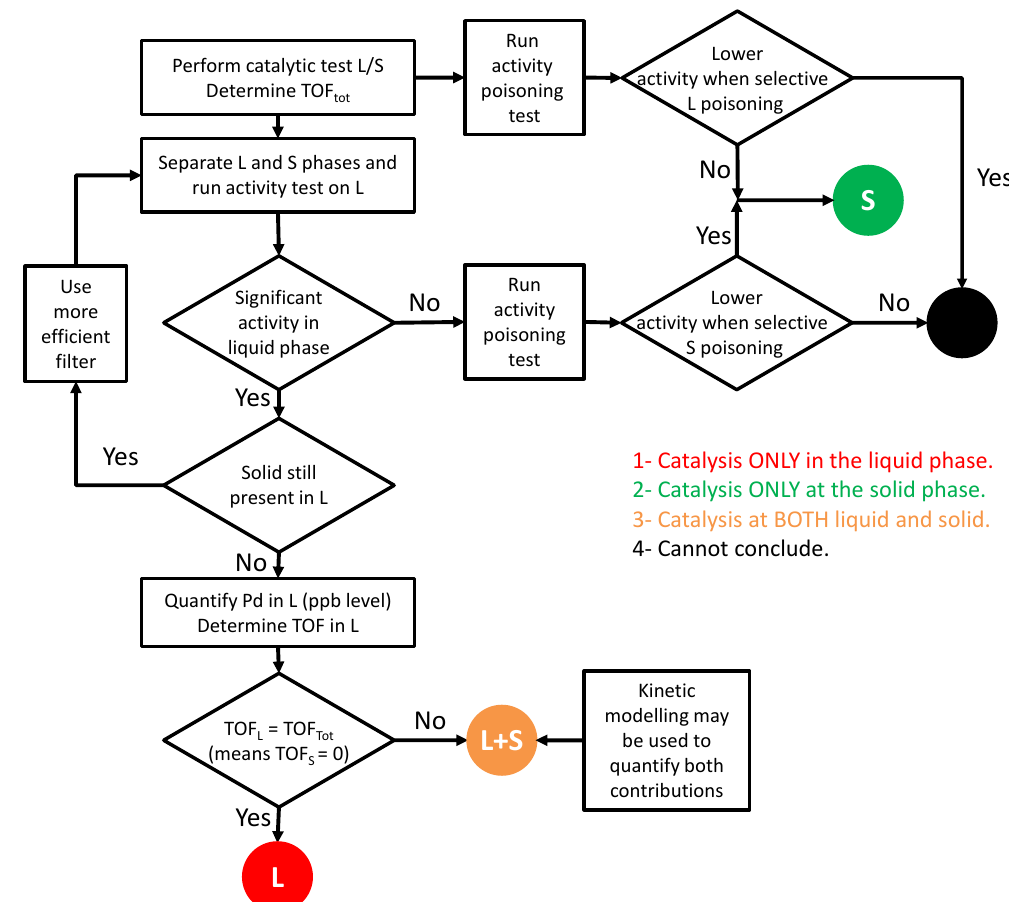
Figure 4. Possible decision tree to try to discriminate homogeneous (L) and heterogeneous (S)